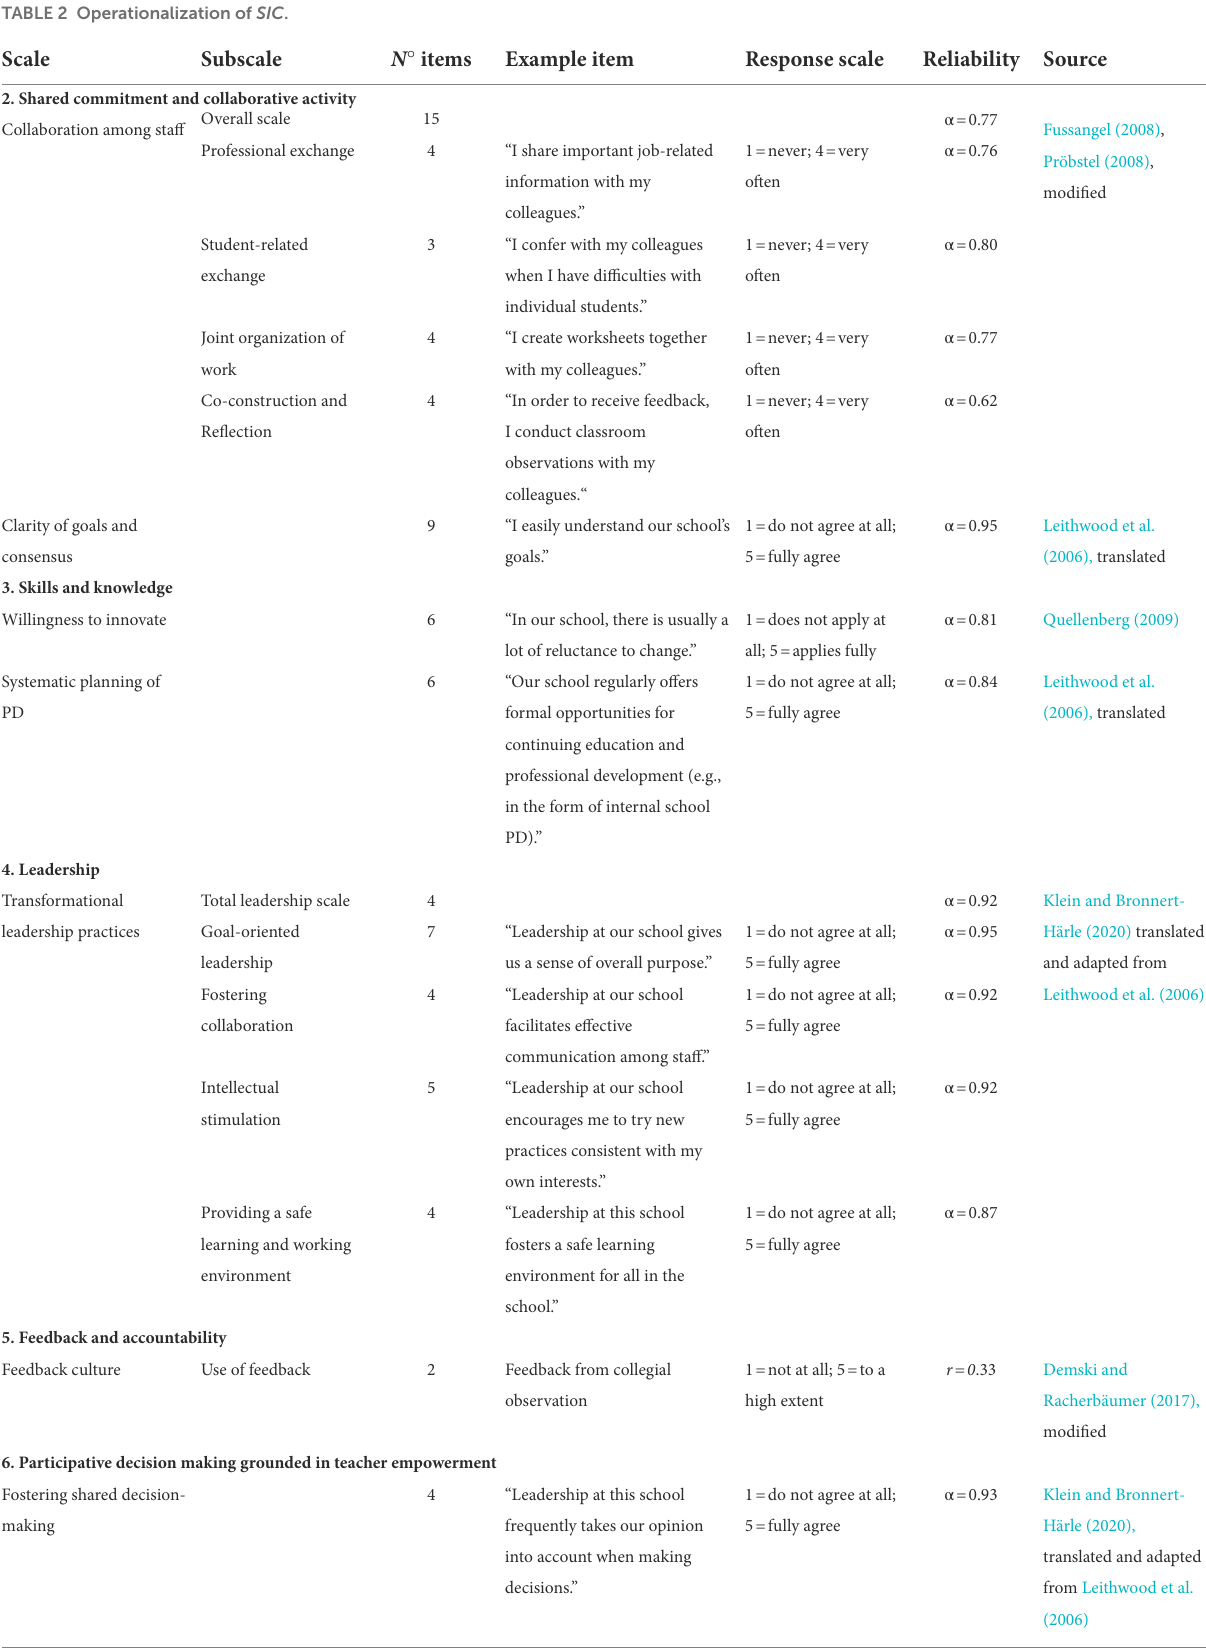
TABLE 2 Operationalization of SIC